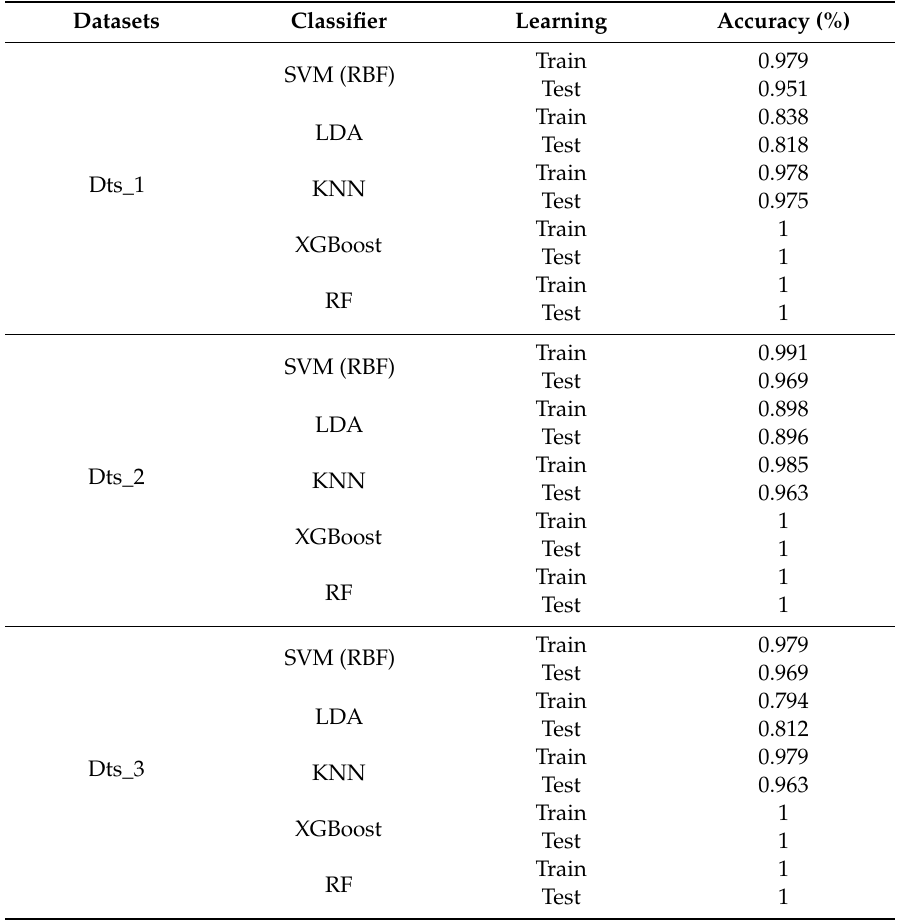
Table 7. Training and testing results for the generated classifier.